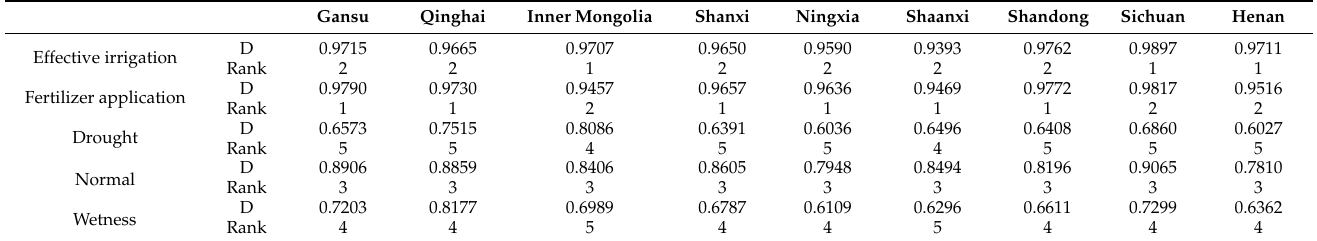
Table 6. Grey correlation degree between grain yield per unit area and related influencing factors in Yellow River basin from 1999 to